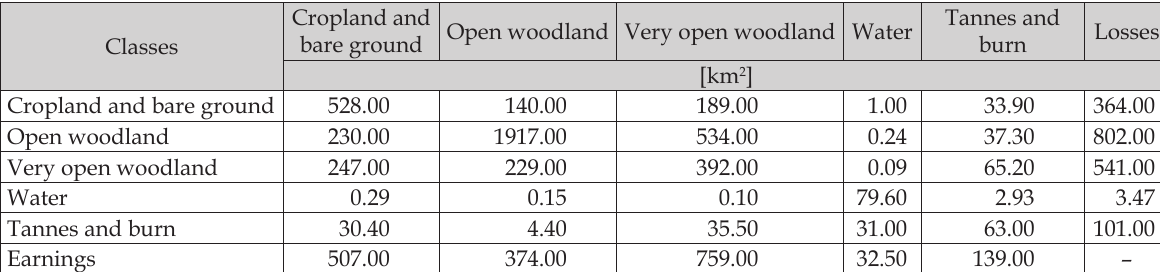
Table 7. Matrix of land use changes between 2000 and